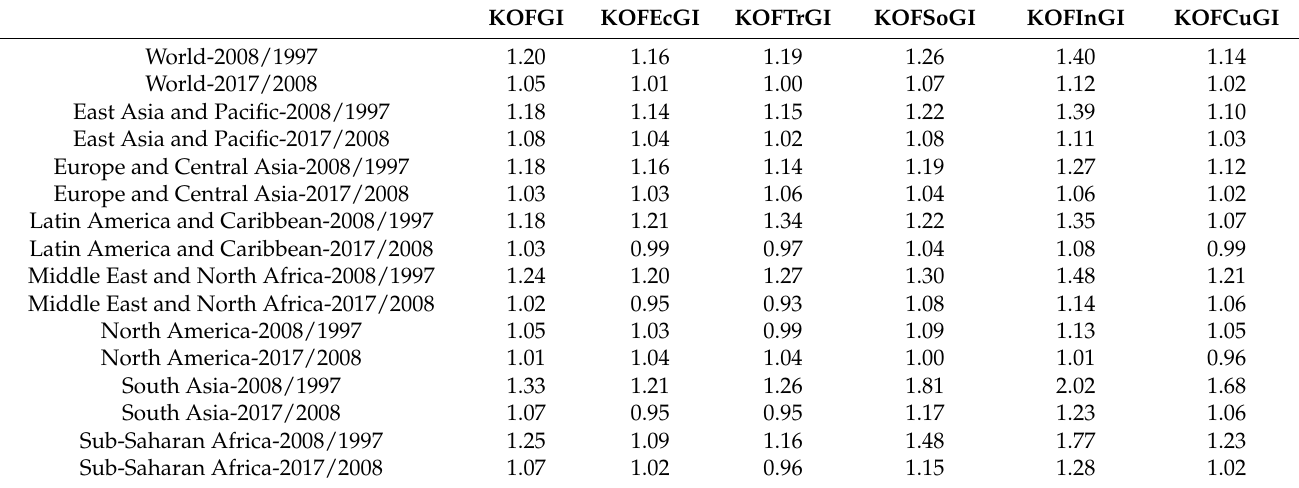
Table 3. Changes in globalisation processes from 1997 to 2017. KOFGI KOFEcGI KOFTrGI KOFSoGI